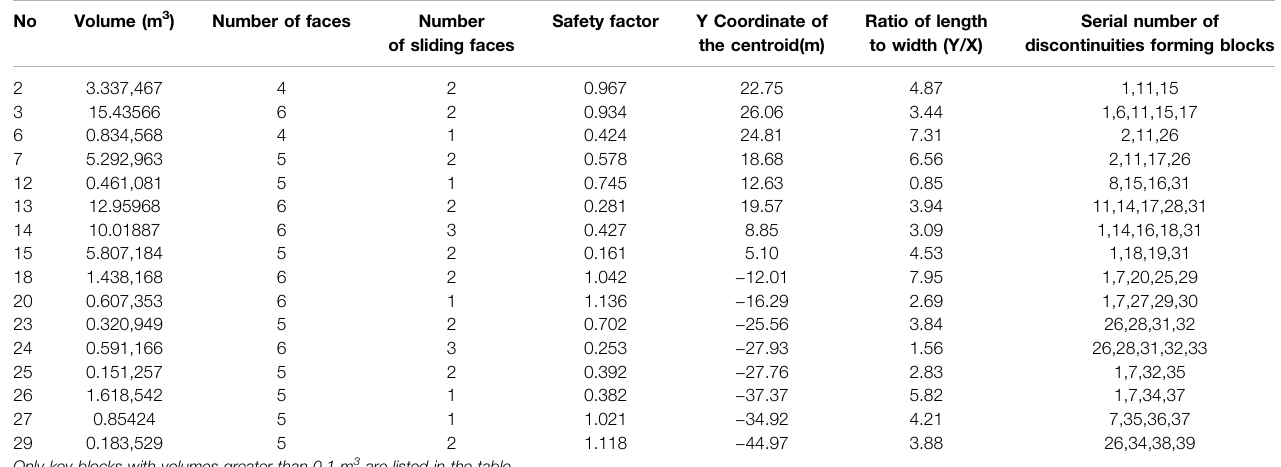
TABLE 2 | The information of key